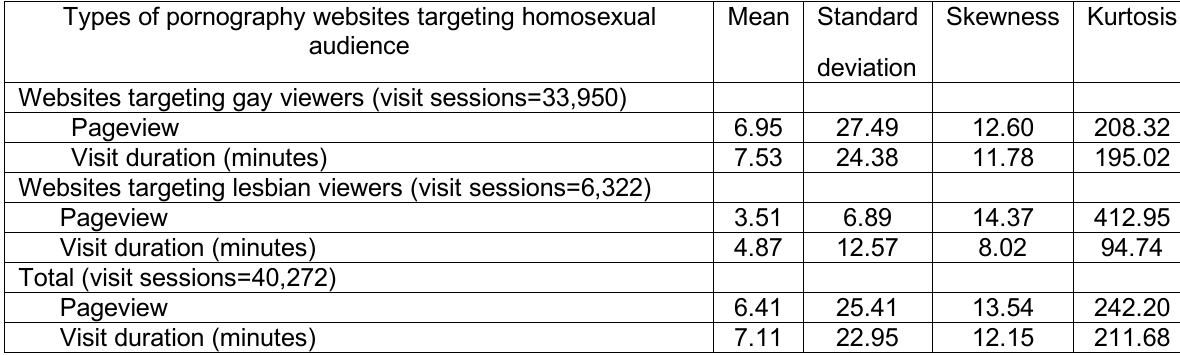
Table 3: Descriptive statistics of pageview and visit duration classified by two types of pornograph websites satisfying homosexual viewers